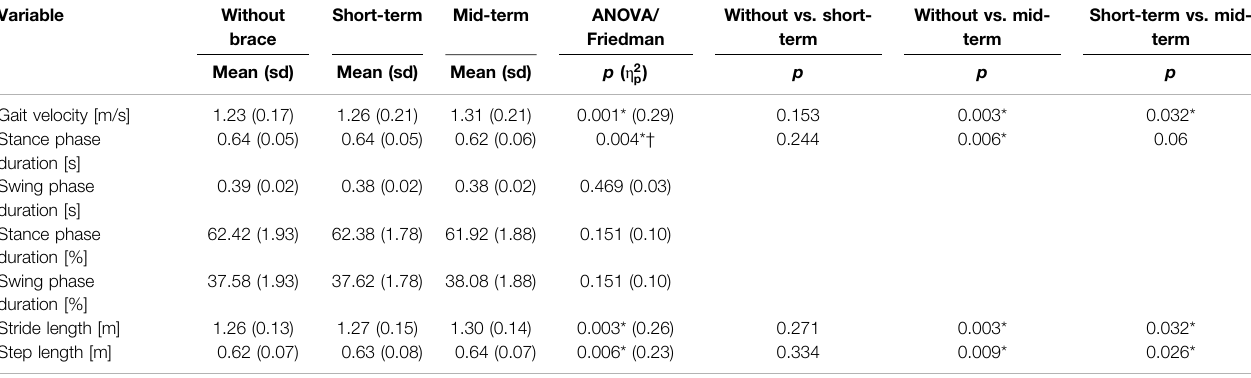
TABLE4| Meanvaluesandstandarddeviations(sd)oftemporal-spatialgaitparametersfortheHOAgroupwithrespectivep-valuesandeffectsizesasrevealedbyone-way repeated measures ANOVAs/Friedman tests and Holm-Bonferroni corrected pairwise comparisons. Level of signi fi cance ≤ 0.05; * marks a signi fi cant result; † marks analysis with a Friedman test.